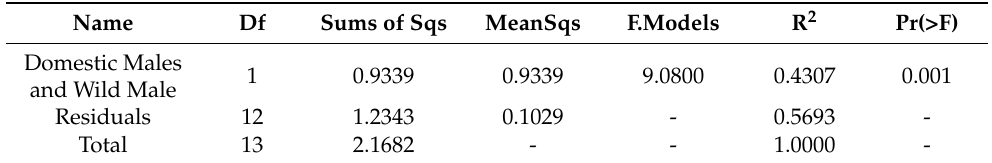
Table A3. Results of the PERMANOVA analysis of the gut microbial diversities between domestic males and wild males.